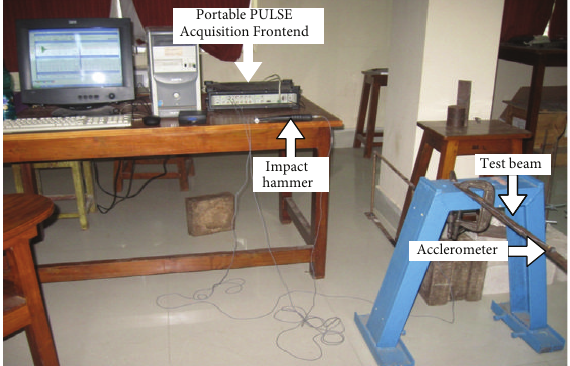
Figure 1: Experimental